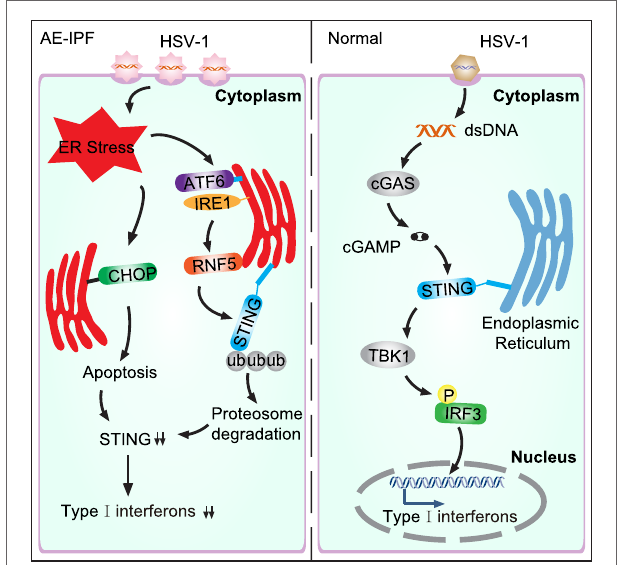
FigUre 8 | Schematic diagram of virus-induced endoplasmic reticulum (ER) stress and the consequent downregulation of the stimulator of interferon genes (STING) pathway in acute exacerbation of idiopathic pulmonary fibrosis (AE-IPF). In normal condition, herpes simplex virus type 1 (HSV-1) infection activates the cytosolic DNA sensor, cyclic GMP-AMP synthase (cGAS), which then generates cGAMP. cGAMP binds STING and activates the downstream signaling pathways. TANK-binding kinase 1 (TBK1) is subsequently recruited to phosphorylate IFN regulatory factor 3 (IRF3), leading to type I interferons expression. In AE-IPF, severe viral infection activates ER stress and unfolded protein response (UPR), which then promotes STING degradation via stimulating RNF5. ER stress induces apoptosis, which further decreases STING production and downregulates type I